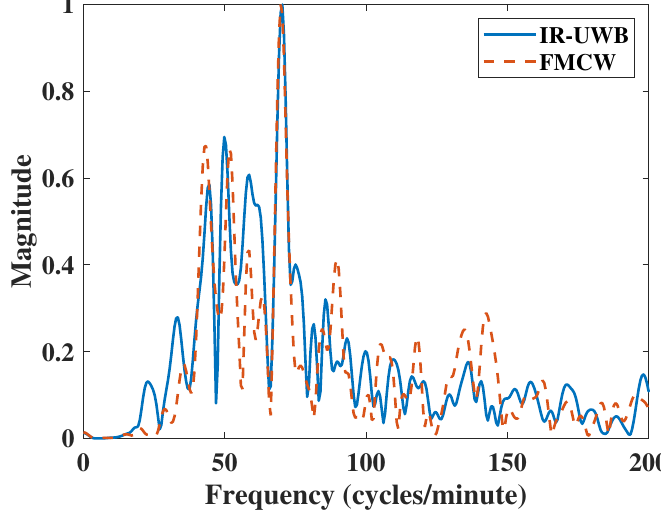
Figure 8. HR Results of Carotid Pulse